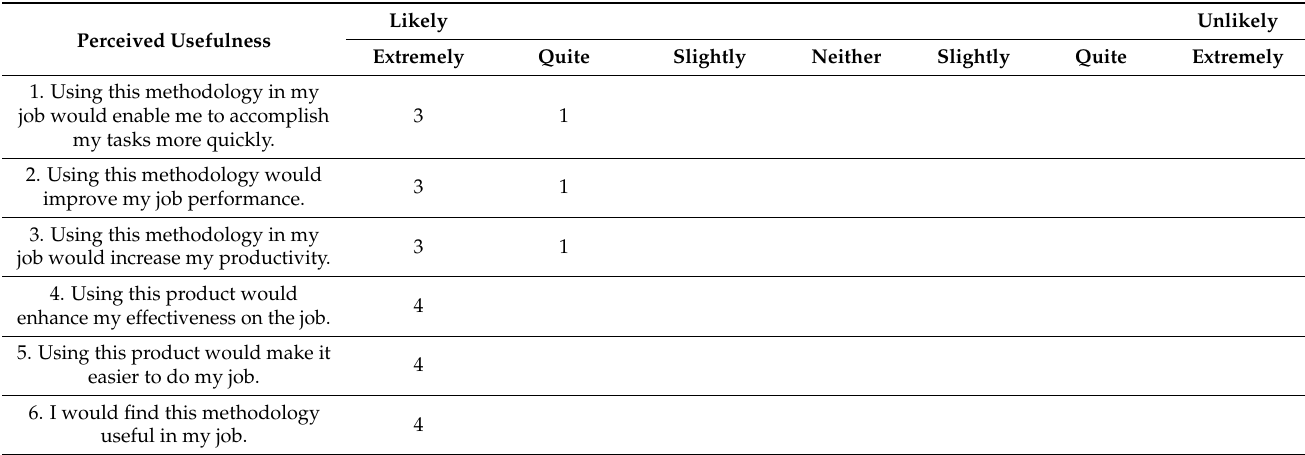
Table 10. Technology Acceptance Model Perceived Usefulness.